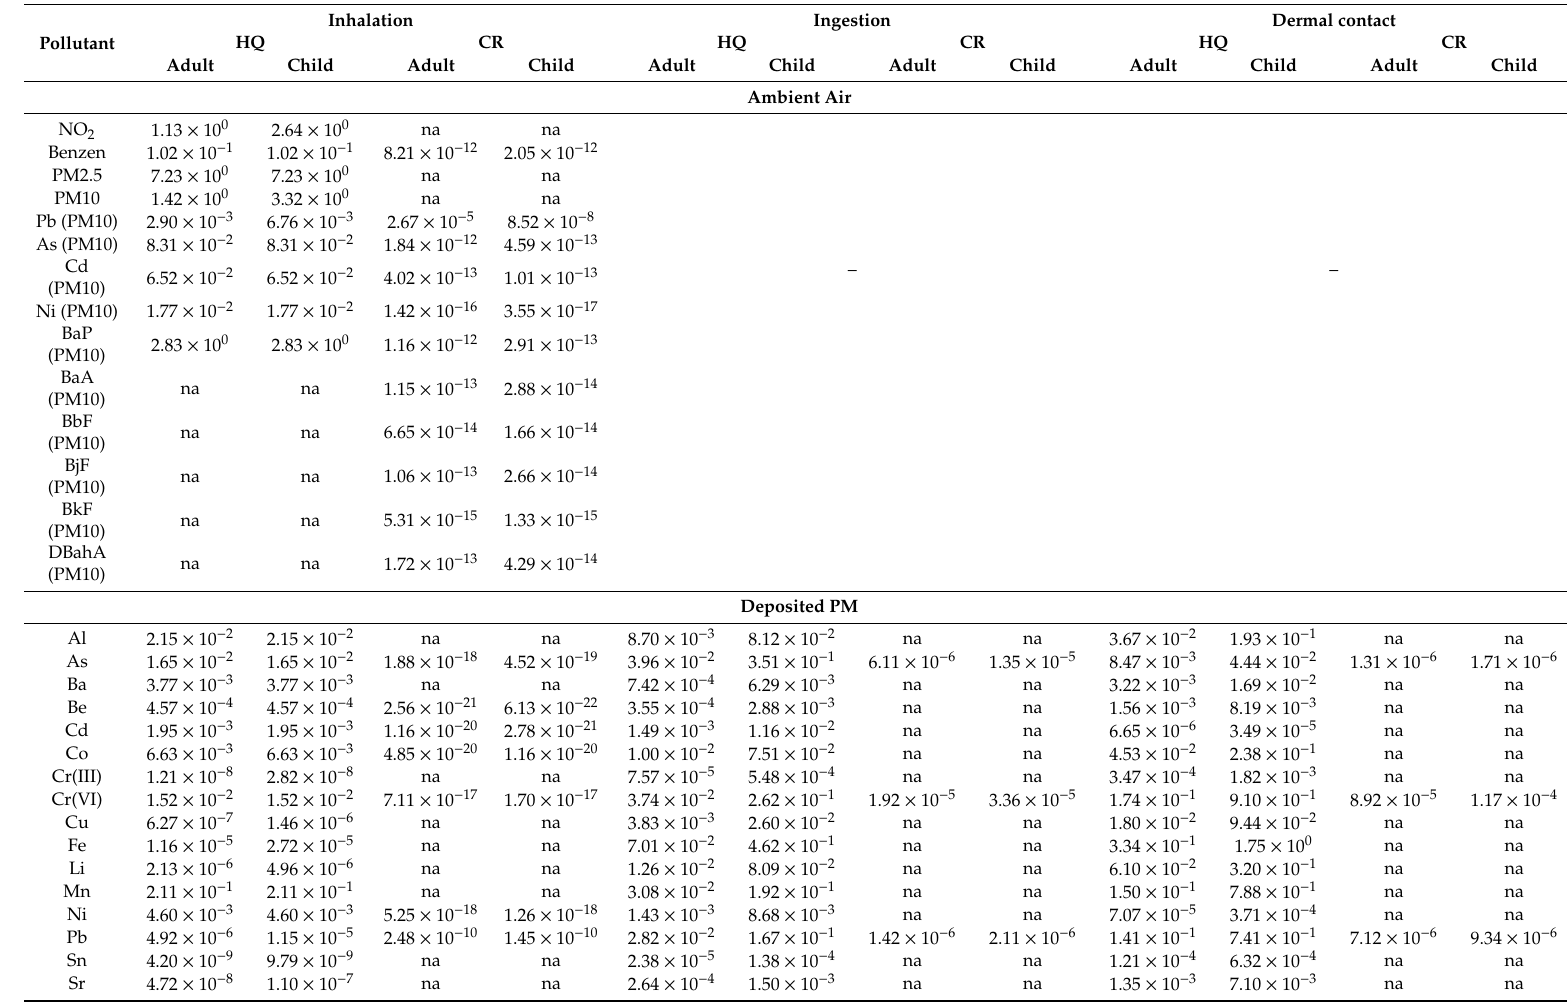
Table 7. Risk assessment values for the residents of Krak ó